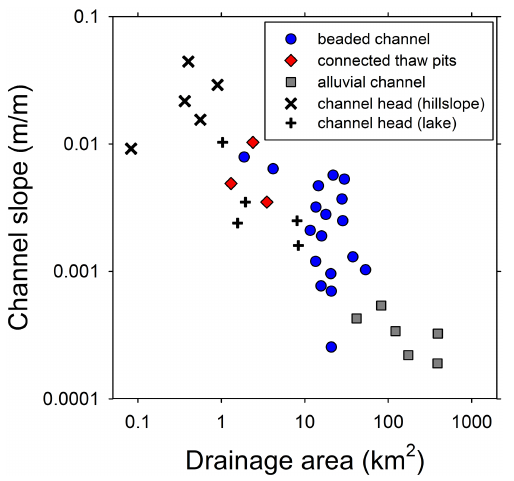
Figure 7. The organization of the major channel forms and channel initiation points (heads) in the Fish Creek watershed are shown in relation to drainage area and channel slope (measured from a 5m DEM).